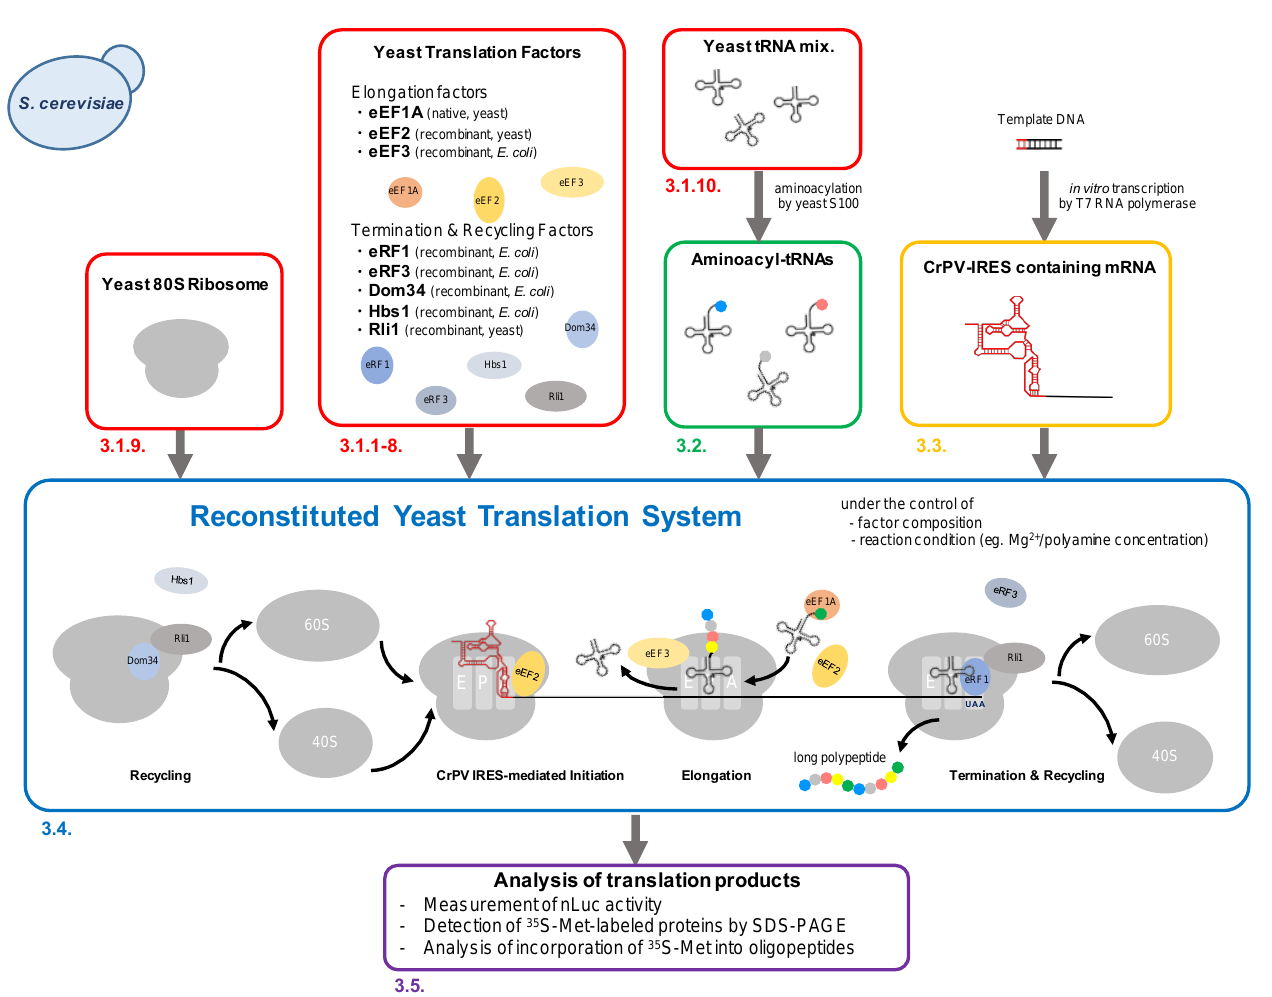
Figure 1. Schematic overview of reconstitution of yeast translation system capable of synthesizing long polypeptides and recapitulating the programmed ribosome stalling. Each procedure is described in the section shown below the rectangle. See the “Experimental Design” section for